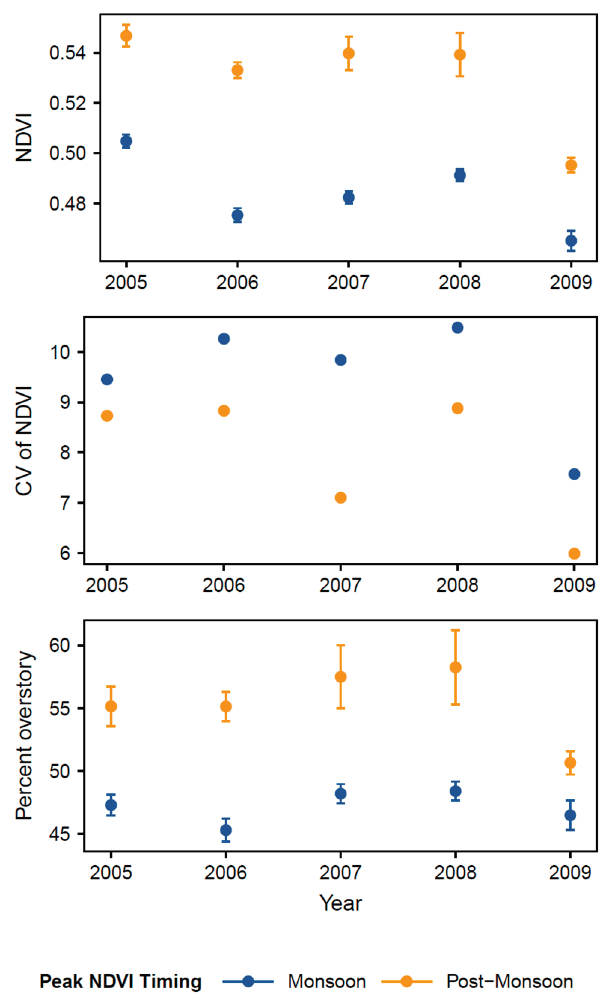
Figure 9. Results of Welch’s t -tests for landscape and vegetation parameters by monsoon or post-monsoon annual peak greenup in each year from 2005 to 2009 for 800 random point locations across the ponderosa pine ecosystem. Mean NDVI ( top ), coefficient of variation (CV) of NDVI ( middle ), and percent overstory cover ( bottom ) were significant at p < 0.05 in all years. Error bars in the mean NDVI and overstory cover plots represent +/ − one standard